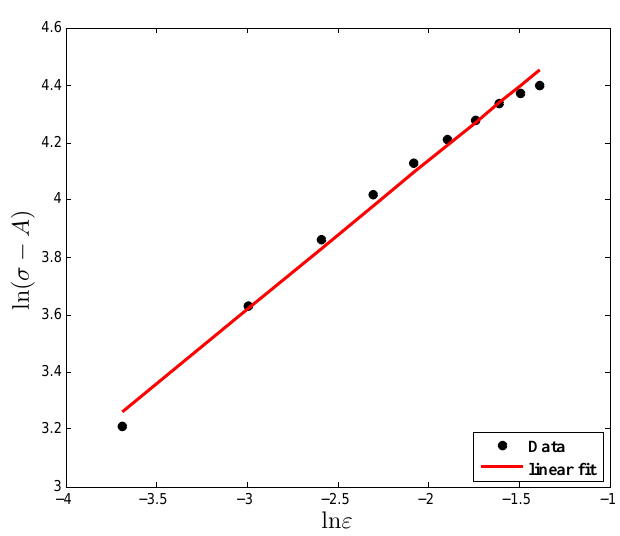
Figure 3. Relationship between ln ( σ − A ) and ln ε under the reference